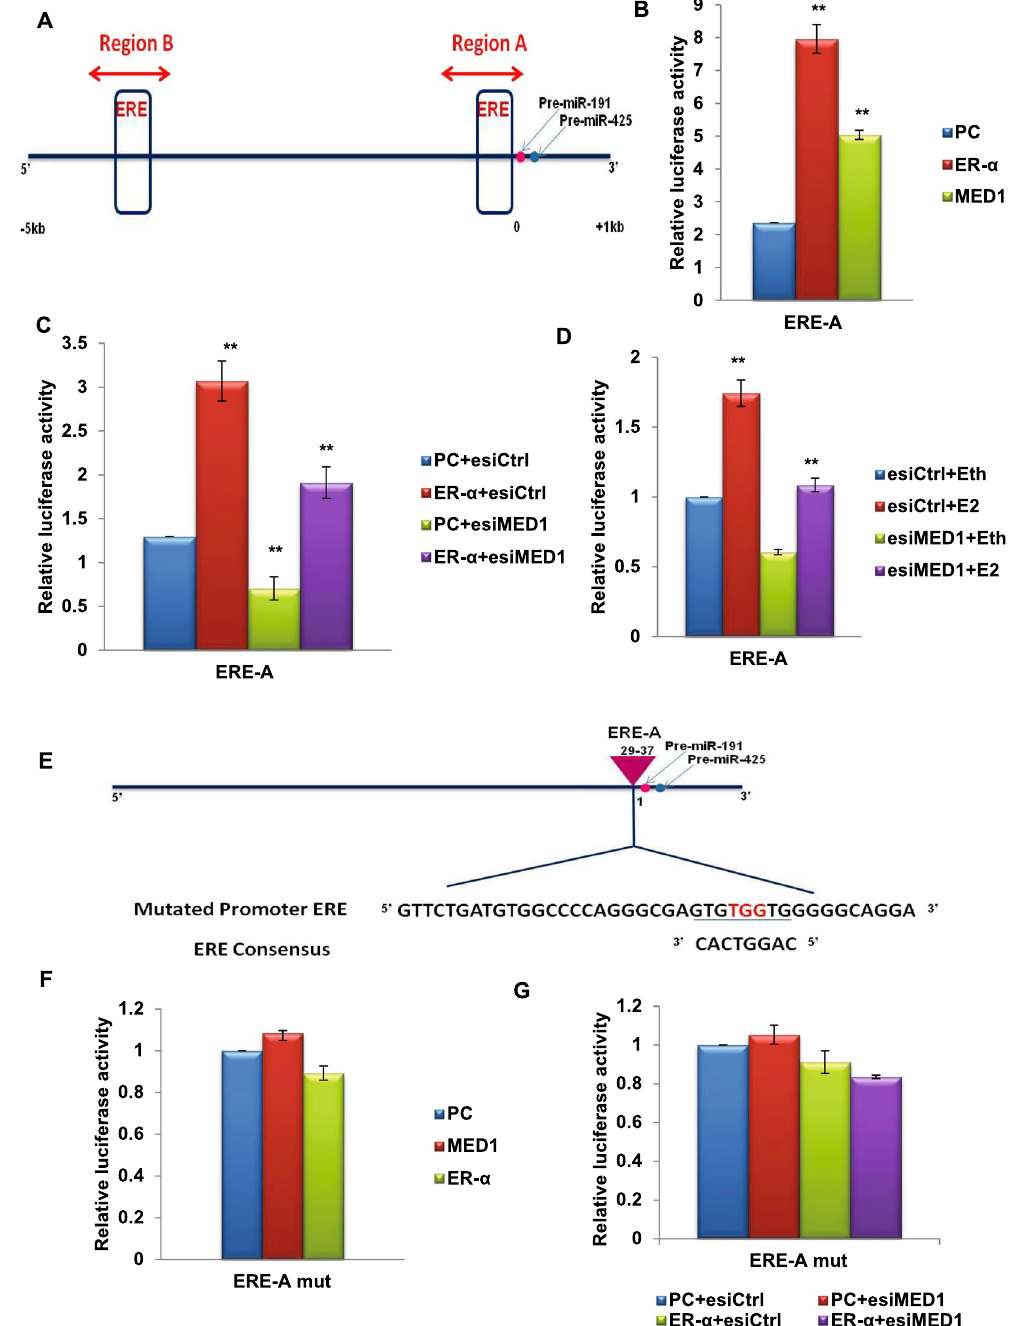
Figure 4. ERE present upstream of miR-191/425 cluster is responsive to ER- α or MED1 overexpression. ( A ) Diagram showing ERE consensus sequences in region upstream of pre-miR-191 using Promo 3.0 software. The locations of the two regions (ERE-A and ERE-B) used for luciferase promoter assays are marked. ( B ) Graph showing luciferase activity of ERE-A luciferase construct of miR-191/425 cluster in response to ER- α or MED1 overexpression. ( C , D ) Estrogen or ER- α mediated effect on luciferase activity of ERE-A construct when coupled with MED1 inhibition. Levels of MED1 were modulated (using esiMED1/esiCtrl) with/without ER- α overexpression or estrogen stimulation (10 − 9 M E2; estrogen or 10 − 9 M Eth; ethanol) and effect on luciferase activity of ERE-A (luciferase constructs of miR-191/425 cluster) was observed. Increase in luciferase activity in response to ER- α ( C ) or estrogen treatment ( D ) was not observed when estrogen stimulation was given along with inhibition of MED1. ( E ) Diagram showing wild type/mutated ERE-A region upstream of miR-191/425 cluster. ( F , G ) Graph showing promoter luciferase activity of ERE-A mut (luciferase constructs bearing mutated ERE site), in response to differential expression of ER- α and MED1 alone ( F ) or in combination ( G ). The graphical data points represent mean + S.D of at least three independent experiments ( ** P < 0.05). Error bars denote +